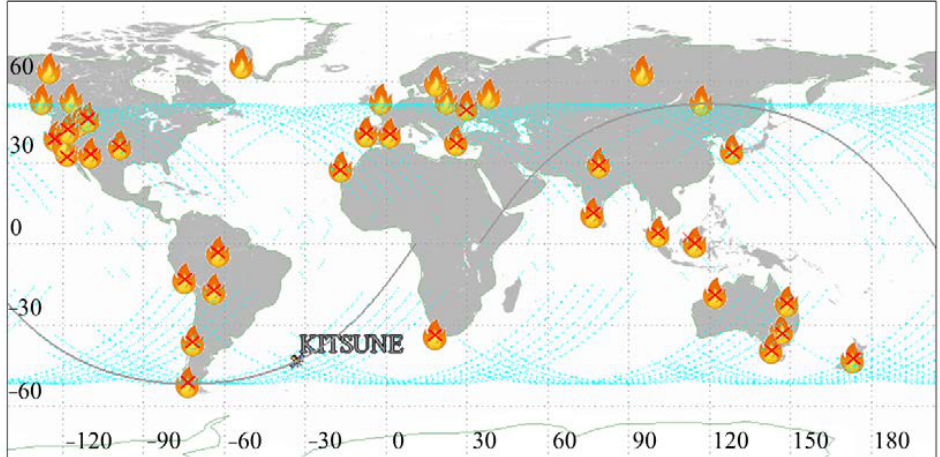
Figure 7. Satellite track (blue dotted lines) of KITSUNE between January and March 2022.